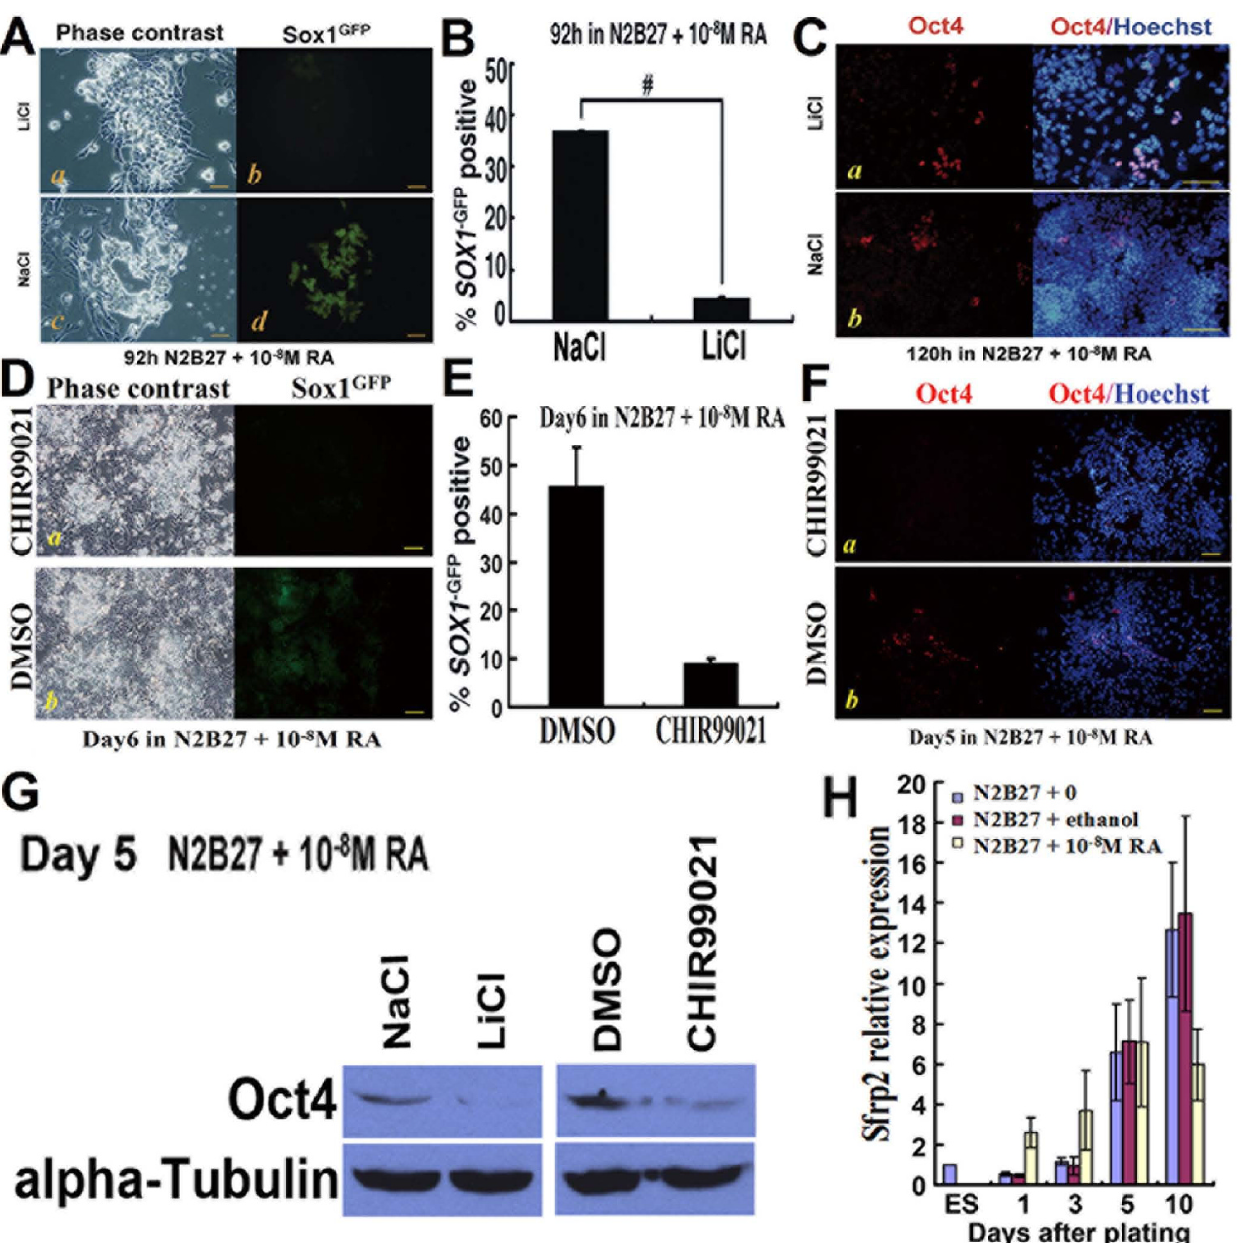
Figure 5 Wnt signaling is involved in RA-promoted neural specification . A-C , Monolayer differentiation of 46C ESCs in RA- treated cultures (N2B27 + 10 -8 M RA) exposed to the GSK-3 inhibitor LiCl (10 mM) or to NaCl (10 mM); A , Cultures of mon- olayer differentiation, shown in phase contrast or stained for Sox1 GFP ; B , Percentage of Sox1 GFP + cells scored by FACS. #, sig- nificant difference between inhibitor-treated cultures and NaCl-treated cultures (p < 0.001); C , Cultures of monolayer differentiation, shown in stained for Oct4 or combination of Oct4 and Hoechst; D-F , Monolayer differentiation of 46C ESCs in RA-treated cultures (N2B27 + 10 -8 M RA) exposed to the GSK-3 inhibitor CHIR99021 (3 μ M) or to equivalent amounts of DMSO diluents; D , Cultures of monolayer differentiation, shown in phase contrast or stained for Sox1 GFP ; E , Percentage of Sox1 GFP + cells scored by FACS; F , Cultures of monolayer differentiation, shown in stained for Oct4 or combination of Oct4 and Hoechst; G , Western blot analysis of Oct4 at day 5 under monolayer cultures; H , Q-PCR for Sfrp2 during monolayer dif- ferentiation. Scale bars: A, 40 μ m; C, D, F, 80 μ